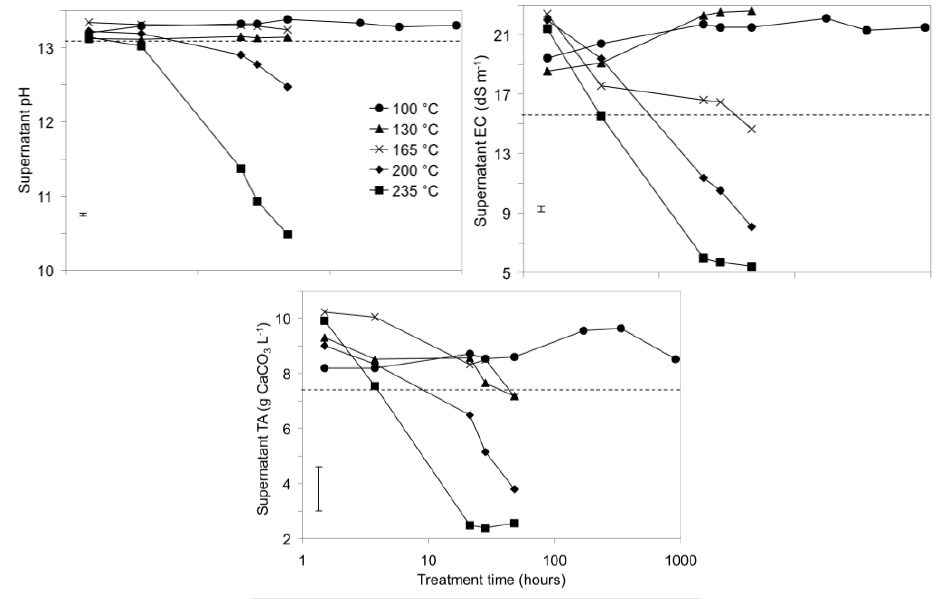
Figure 1. pH, EC, and total alkalinity (TA) of supernatants from bauxite residue during pressure vessel treatments at various temperatures. Dashed lines indicate t = 0 values. Note that treatment time ( X axis) is graphed on a logarithmic scale. Error bars indicate 95% confidence interval for the mean of the 100 °C treatment at 909